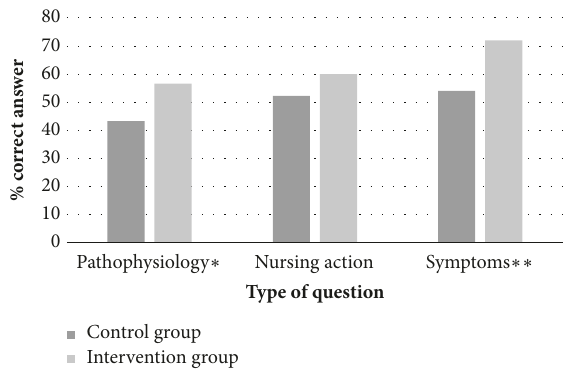
Figure 1: Posttest knowledge scores before and after the interven- tion. ∗ p=0.001 ∗∗ p <